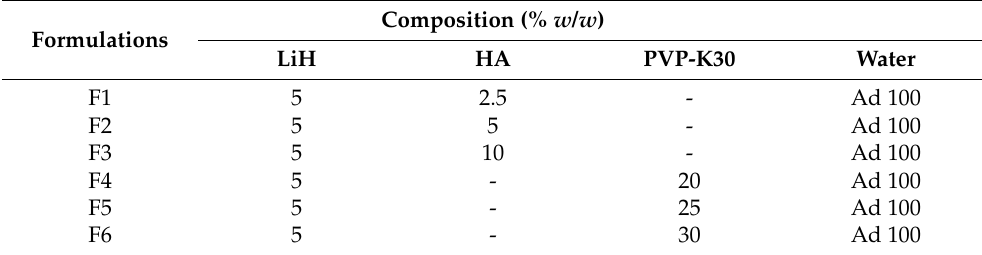
Table 1. The composition of LiH-Loaded